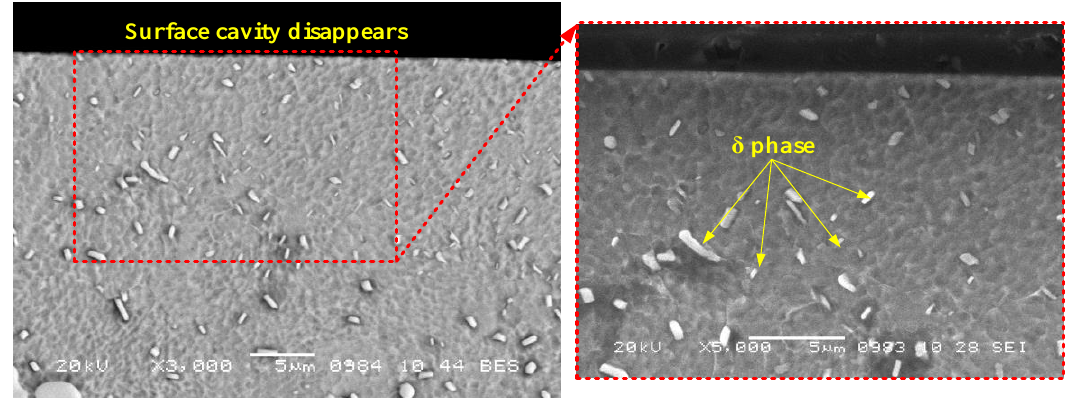
Figure 7. Microstructures of GH4169 alloy: ( a ) FT process and ( b ) TCP process.